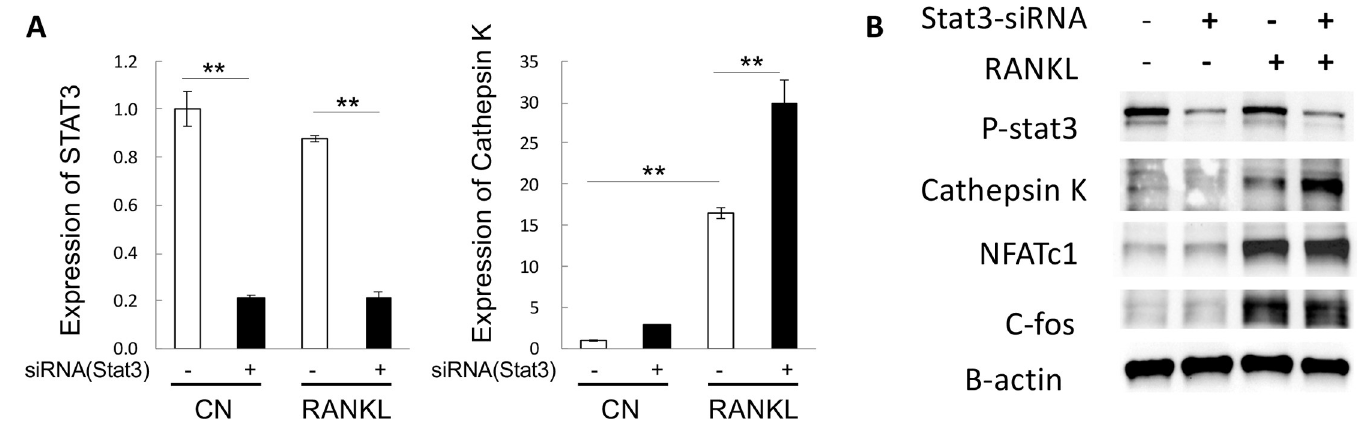
Fig 6. STAT3 is a negative regulator of the expression of cathepsin K. RAW264.7 pre-osteoclastic cells were transfected with Stat3 siRNA and stimulated with RANKL. A) The expression of STAT3 and cathepsin K transcripts was determined by qPCR. Stat3 mRNA was significantly reduced by Stat3 siRNA. Cathepsin K mRNA was increased by RANKL stimulation by seven fold and further significantly increased by Stat3 siRNA knock down in the RAW264.7 cell by two fold. B) Western blot analysis of proteins expressed in differentiated osteoclasts. After 24 hour siRNA-Stat3 treatment, phosphorylated STAT3 (p-STAT3) was noticeably reduced by Stat3 siRNA. Cathepsin K, NFATc1 and c-fos were markedly increased in response to RANKL treatment. However, only the expression of cathepsin K was further increased in cells treated with both RANKL and Stat3 siRNA knock down. Three independent cell experiments were carried out. �� p < 0.001.